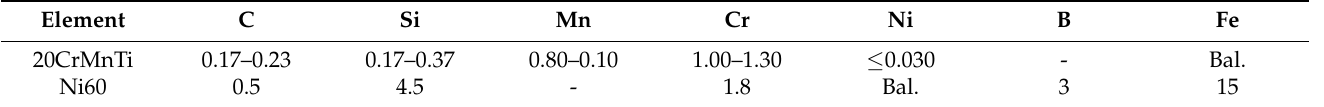
Figure 1. SEM image of Ni60 alloy powder: ( a ) geometry shape of Ni60, ( b ) size statistic of Ni60. Table 1. The component of Ni60 and 20CrMnTi (wt. %).